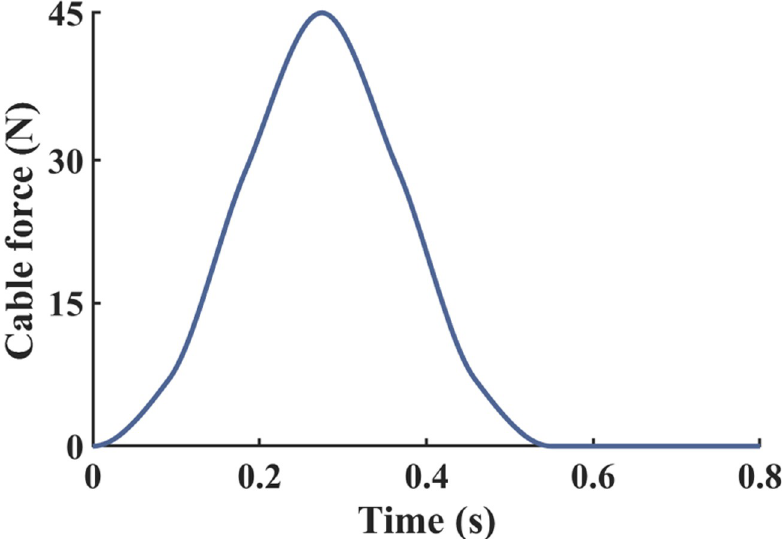
PLOS ONE | https://doi.org/10.1371/journal.pone.0263176 February 10,